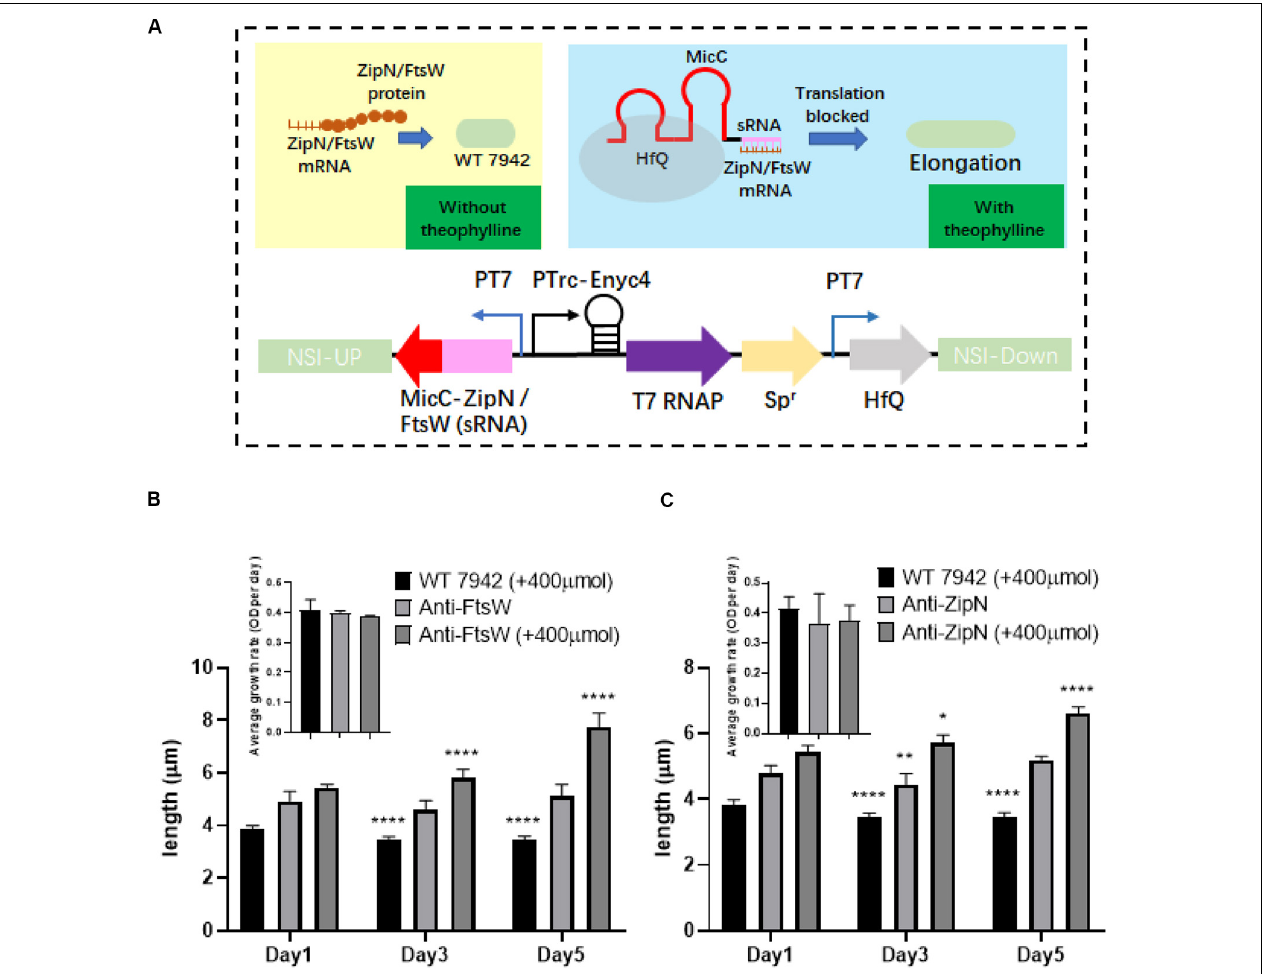
FIGURE 5 | Regulation of PCC7942 cell lengths through the adoption of sRNA based gene repression approach. (A) Design of the Hfq-MicC sRNA approach for controllable repression of ZipN or FtsW to regulate cell lengths of PCC7942. (B) The dynamics of cell lengths of the PCC7942-Anti-FtsW (B) and PCC7942-Anti-ZipN (C) strains induced with 400 µ M theophylline for 3 days. The inset figures represent the growths of the wild type control and the mutant strains. The Kruskal-Wallis test in One-way ANOVA was used to analyze the significant difference cell length at Day 2 (and Day 3) compared with that at Day 1 for each strain. * indicates < 0.05; ** indicates < 0.01; *** indicates < 0.001; **** indicates <